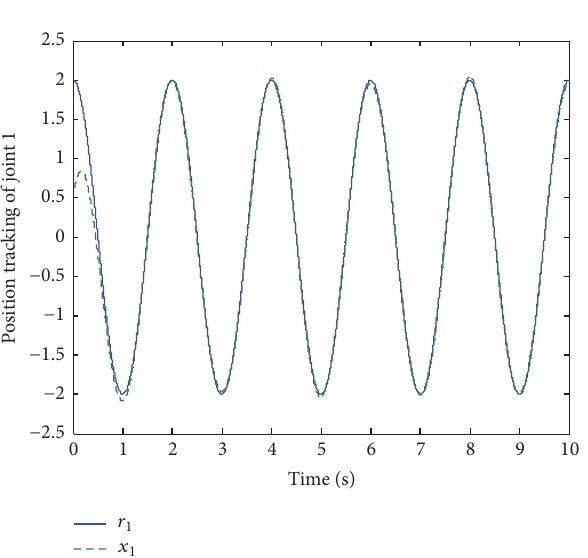
Figure 6: Control input signal 𝑢 2 .